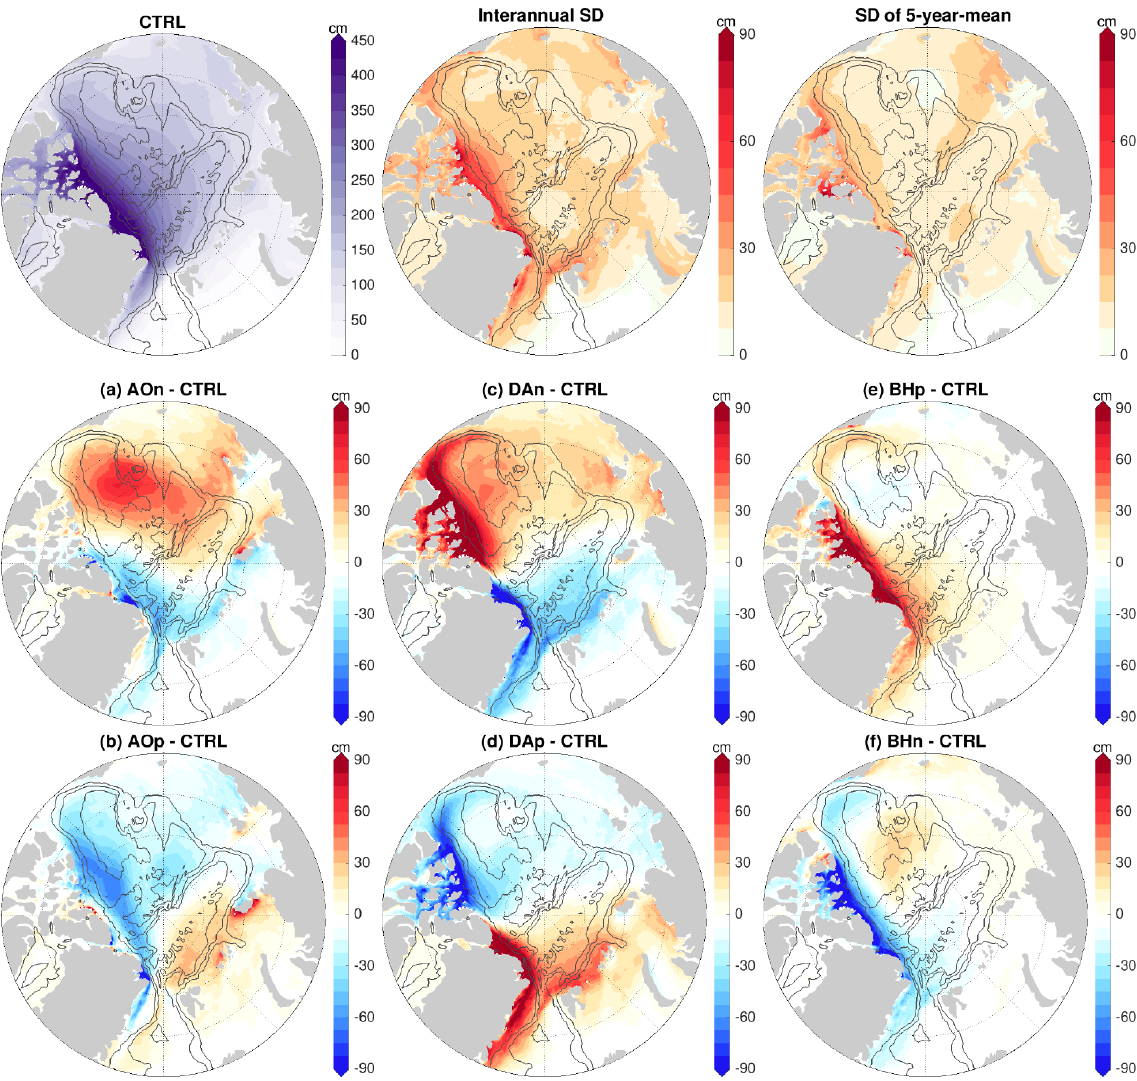
Figure 14. (a–f) Anomaly of sea ice thickness when wind perturbations are kept in the simulations. Experiments with the (a) negative phase of Arctic Oscillation (AO) forcing, (b) positive phase of AO forcing, (c) negative phase of Dipole Anomaly (DA) forcing, (d) positive phase of DA forcing, (e) positive phase of Beaufort High (BH) forcing and (f) negative phase of BH forcing. The anomalies are averaged over 2016–2019 and referenced to the control run result. The mean sea ice thickness in this period (left), the standard deviation (SD) of sea ice thickness on the interannual timescale in the 2010s (middle) and the SD of the pentadal mean in the period 1980–2019 (right) from the control run are shown at the top of the figure for reference. The black contour lines indicate the 500, 2000 and 3500m isobaths. This figure shows the impacts of wind perturbations when they are present; it is to be compared with Fig. 7, which shows the impacts from the ocean’s memory. The direct impacts of winds on sea ice drift, concentration and deformation and their seasonality are shown in Figs. S10–S13 in the